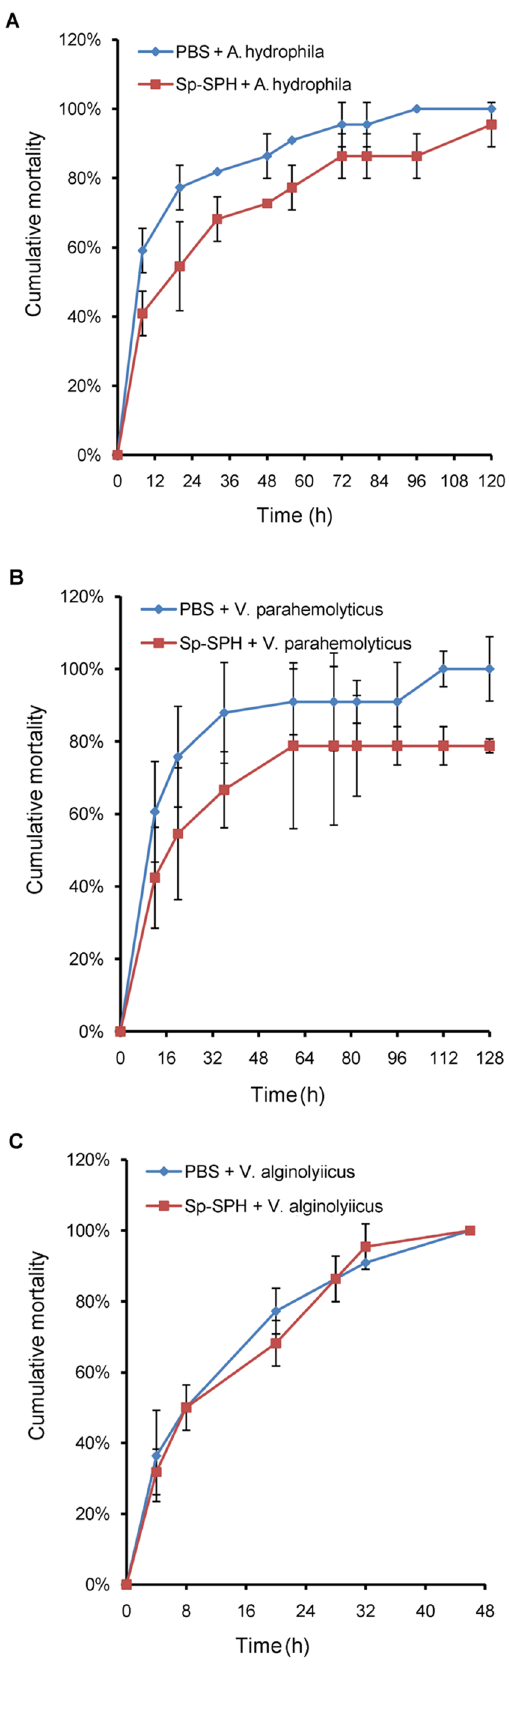
Figure 6. Cumulative mortality of mud crab challenged with bacteria pre-coated with Sp-SPH protein. Crabs were challenged with A. hydrophila , V. parahemolyticus or V. alginolyiicus pre-coated with Sp-SPH protein as described above. Ten animals were used for each group. The mortality was recorded hourly. The cumulative mortality of crabs, in which the bacteria were coated with Sp-SPH protein (square, SPH), was compared with that of animals treated with ‘‘PBS-coated’’ bacteria (diamond, PBS). A: The cumulative mortality caused by A. hydrophila ; B: The cumulative mortality caused by V. parahemolyticus ; C: The cumulative mortality caused by V. alginolyiicus . This experiment was repeated three times and the data represented means of triplicates. Bars indicated mean 6 S.E. ( n